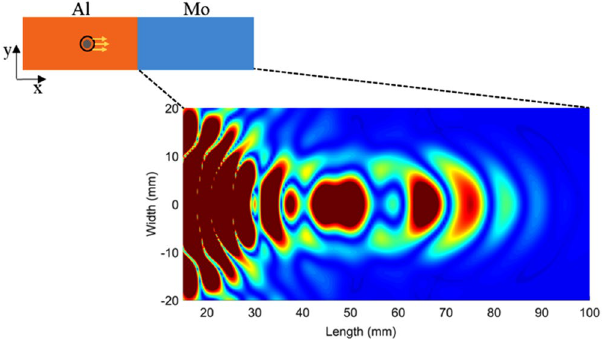
Figure 2. Simulation results showing focusing observed in the Molybdenum section of Al-Mo material contrast lens (see inset for schematic).